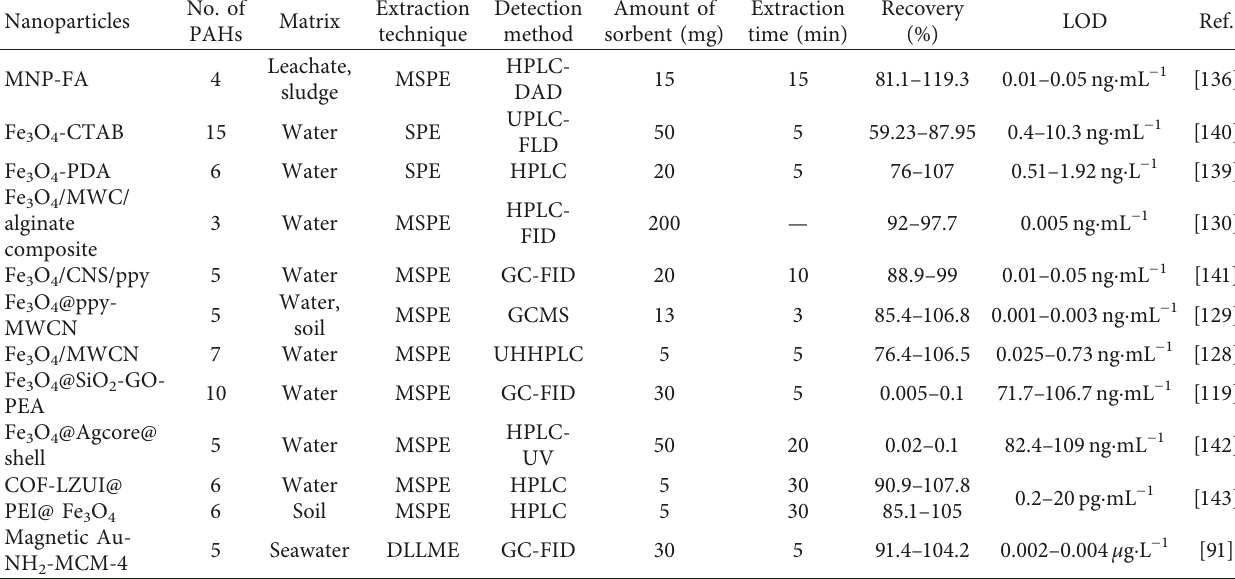
Table 11: Some magnetic and magnetised NPs used in the extraction of